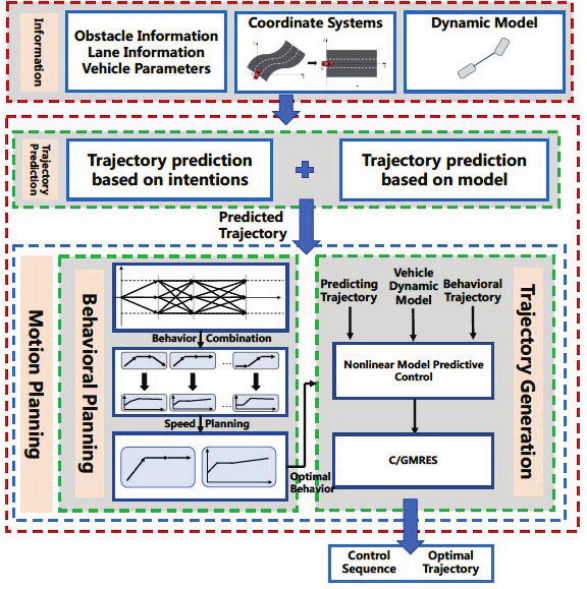
Figure 1. Diagram of the proposed motion planning